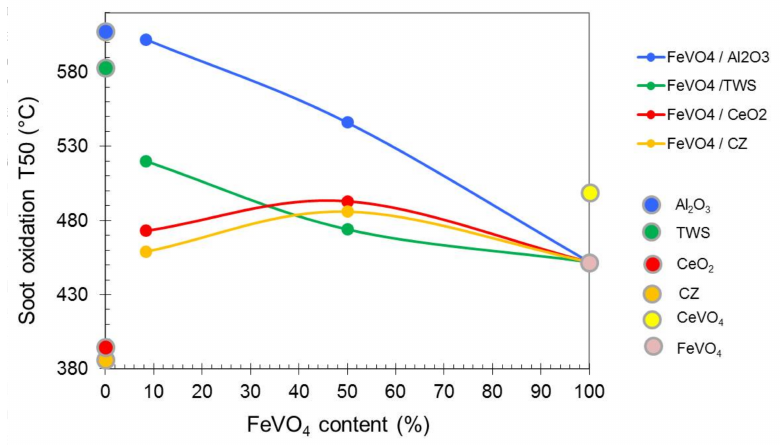
Figure 4. Effect of vanadate loading on soot oxidation